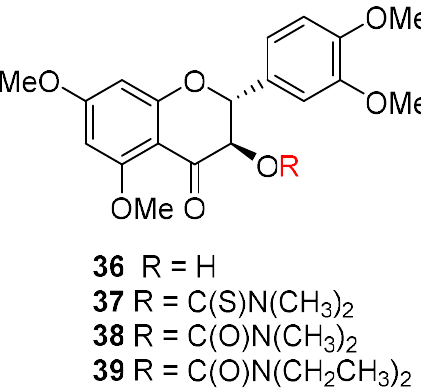
Figure 5. Chemical structures of taxifolins.